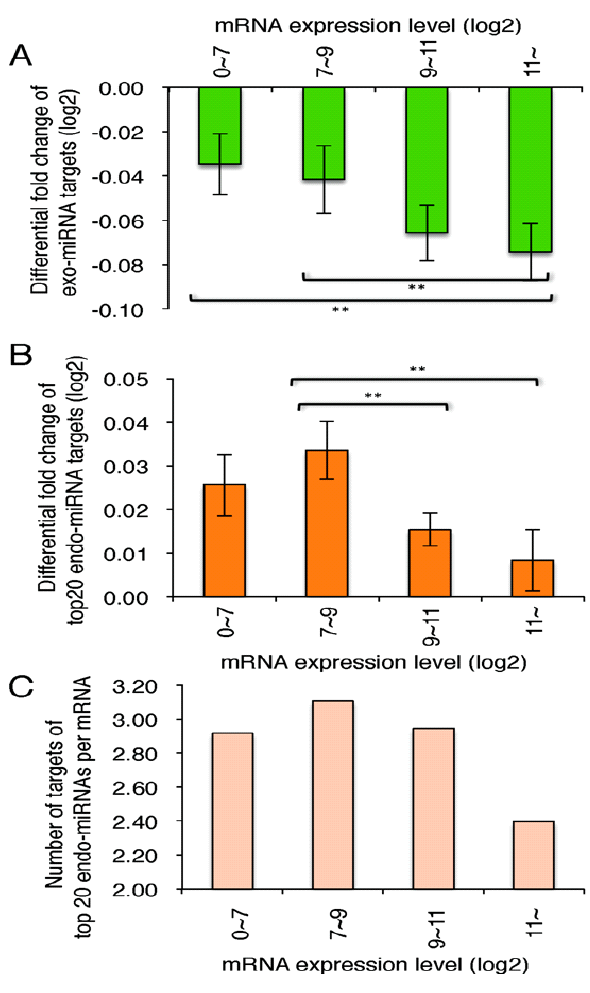
Figure 6. Mean fold changes of target genes of exo-miRNAs and endo-miRNAs, according to the expression levels. Differential fold changes (log expression levels of exo-miRNAs ( A ) and endo-miRNAs ( B ) and the number of the top 20 endo-miRNA target sites ( C ), according to the expression levels of exo-miRNA targets. The averaged numbers of exo-miRNA target sites are 130, 217, 237 and 215 ( A ), and those of endo-miRNA target sites are 92, 164, 176 and 202 ( B ) in the 3' UTRs of genes with differential fold changes of 0~7, 7~9, 9~11 and